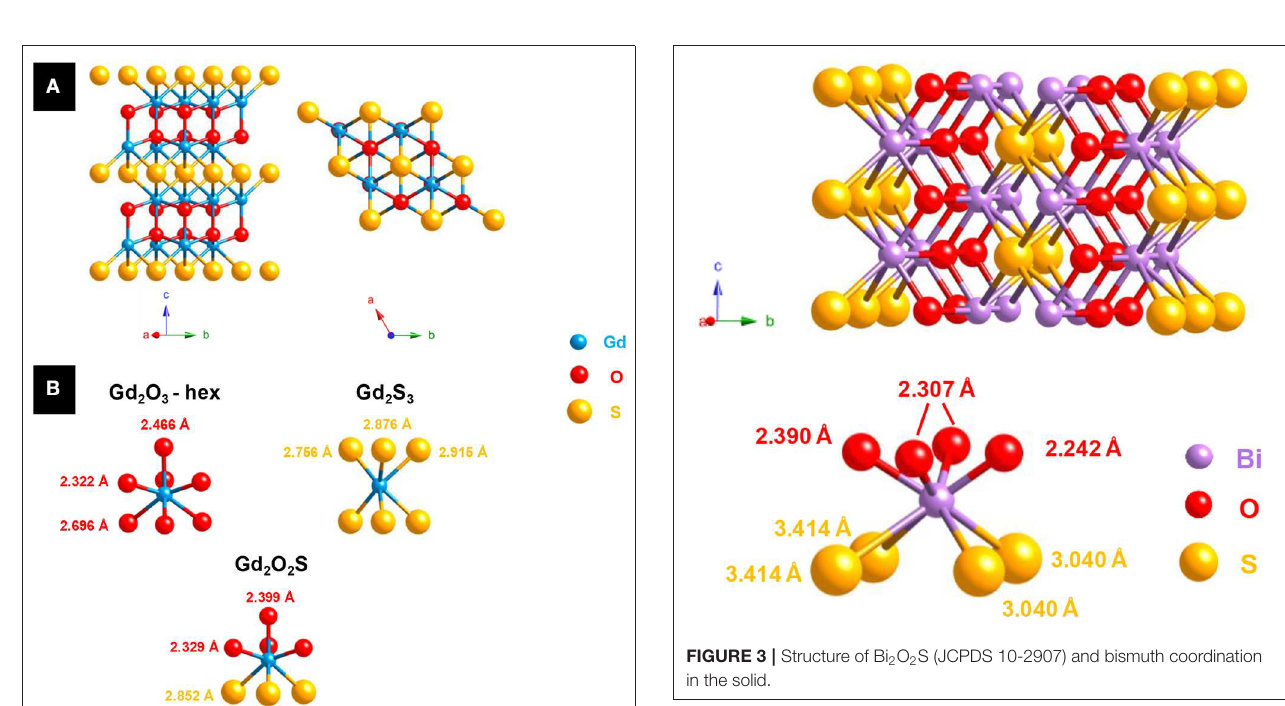
bonds are significantly longer (3.4 Å for Bi 2 O 2 S, < 3 Å for Ln 2 O 2 S). Further works showed that bismuth can form several oxysulfides, leading to superconductive Bi 4 O 4 S 3 (Zhang et al., 2015) (containing both sulfide and sulfate ions) and to Bi 9 O 7.5 S 6 (Meng et al., 2015).